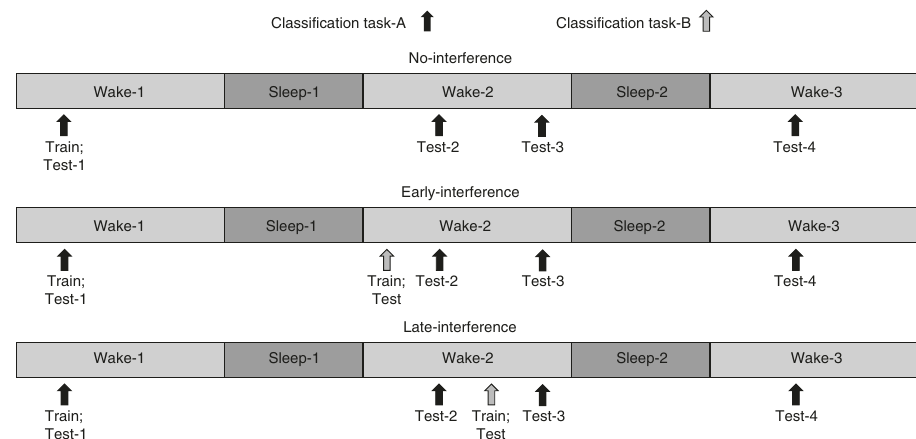
Fig. 1 Experimental design for experiment-1. Thirty-six starlings were trained to classify 5 s segments of novel starling song. Starlings were trained on classi fi cation task-A from 9:30 a.m. to 12:00 p.m. and tested four times thereafter: immediately after training at 12:00 p.m. on day-1 (test-1), at 12:00 p.m. on day-2 (test-2), at 5:30 p.m. on day-2 (test-3), and at 12:00 p.m. on day-3 (test-4). In the interference conditions, starlings also were trained and tested on classi fi cation task-B on day-2, either in the morning from 7:30 a.m. to 11:00 a.m. before task-A was tested (early-interference) or in the afternoon from 1:00 p.m. to 4:30 p.m. after task-A was tested (late-interference). Task-B entailed the same Go/No-Go operant training and testing procedure as task-A but utilized a different pair of novel song stimuli than task-A. Each starling completed all three